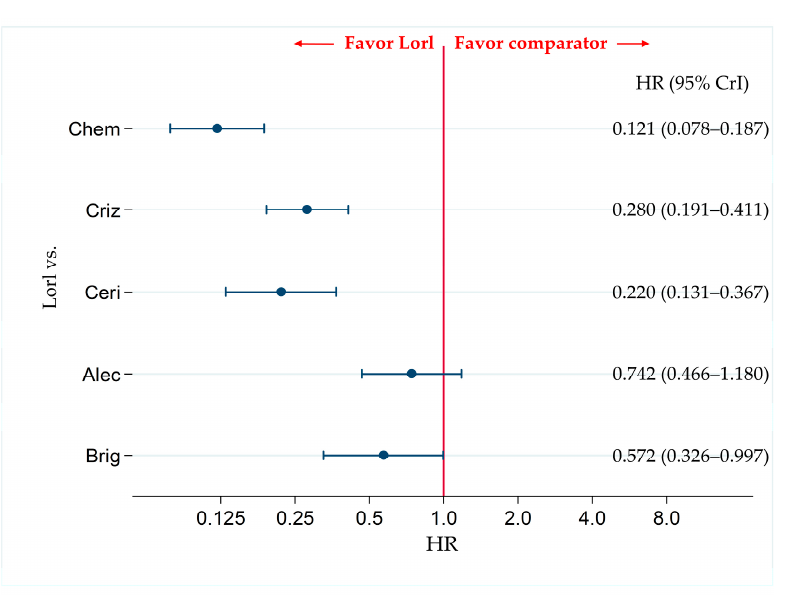
Figure 4. Comparative efficacy of lorlatinib and existing therapeutics in terms of PFS in patients with ALK-p ALK-inhibitor-naïve NSCLC. All eight studies were included for analyzing PFS in the overall participant group. A comparison of PFS in ALK-p ALK-inhibitor-naïve advanced NSCLC patients treated with lorlatinib and each of the other five therapeutic agents including chemotherapy, crizotinib, ceritinib, alectinib, and brigatinib as comparator is presented. Comparisons are expressed as lorlatinib versus each of the comparators. Data are expressed as hazard ratios (HRs) and 95% credible intervals (CrIs). PFS, progression free survival; ALK, anaplastic lymphoma kinase; ALK-p, anaplastic lymphoma kinase-positive; NSCLC, non-small cell lung cancer; Lorl, lorlatinib; Brig, brigatinib; Alec, alectinib; Ceri, ceritinib; Criz, crizotinib; Chem, chemotherapy. 3.3. Subgroup Analysis for the Primary Efficacy Endpoint (PFS) in the Non-Asian and Asian Subgroups